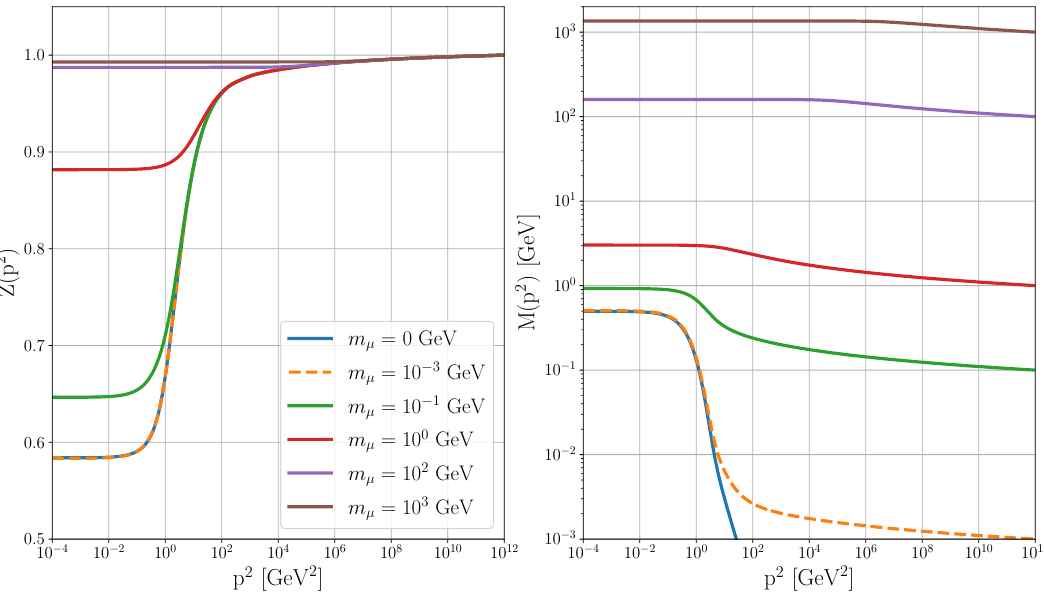
Figure 1: Wave function renormalization Z ( p 2 ) (left) and mass function M ( p 2 ) (right) for fermions in a triplet representation with different current masses m µ , de- fined at the scale µ = 10 6 GeV. For comparison, the chiral limit m µ = 0 is shown as well (blue